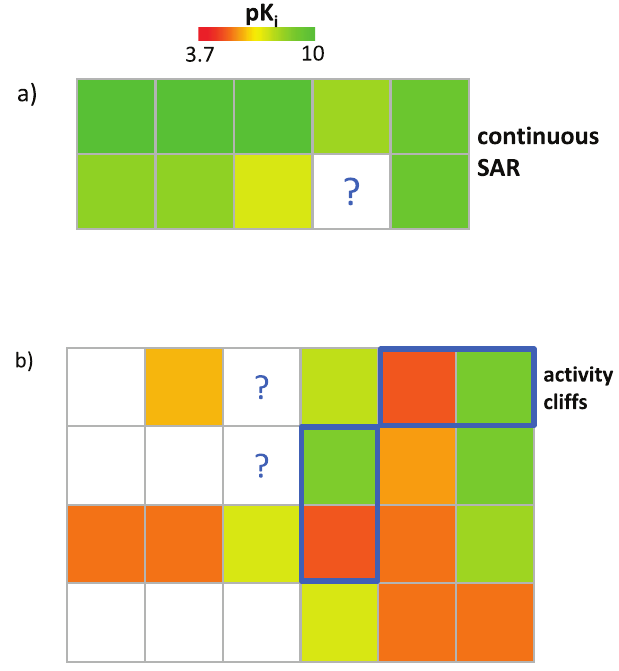
Figure 6. Candidate compound selection and activity prediction. In ( a ), a SARM is shown that represents a highly continuous local SAR environment. In this case, the potency of a virtual compound can be predicted using the NBH-based approach. By contrast, ( b ) shows a SARM representing a discontinuous local SAR. Activity cliff-forming compound pairs are highlighted in blue. Such SAR environments fall outside the applicability domain of NBH-based potency predictions. However, marked VCs represent promising candidates for compound design based on their proximity to activity cliffs. Both SARMs originate from a set of cannabinoid CB1 receptor ligands (compound structures are omitted for